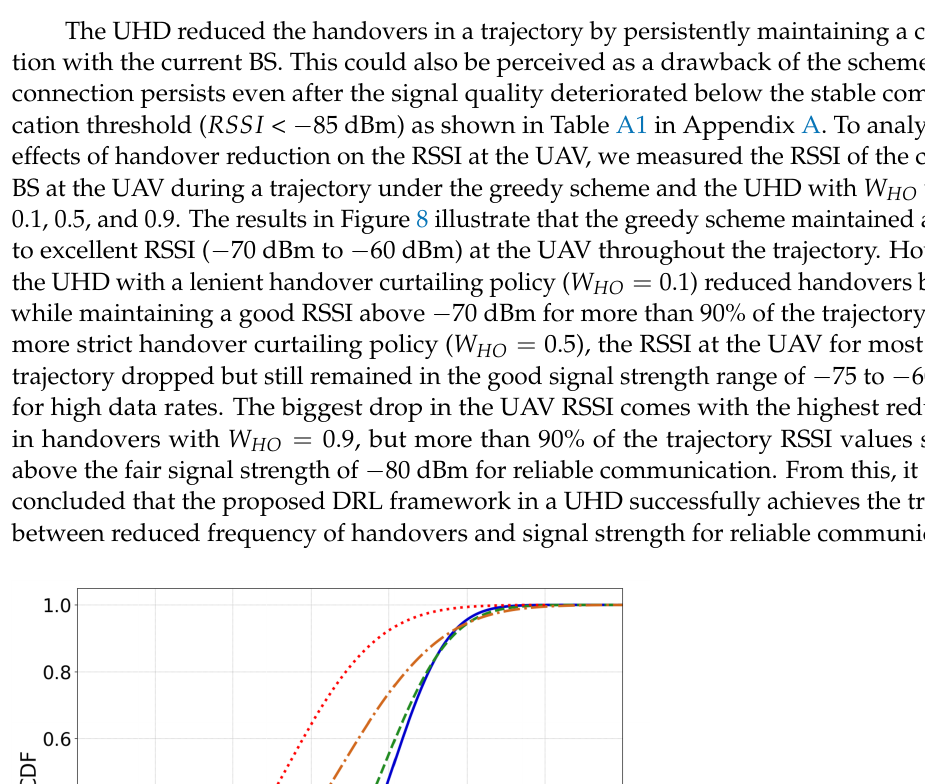
Figure 7. Handovers in a trajectory under greedy and UHD methods with 0.1, 0.5, and 0.9 W HO values.